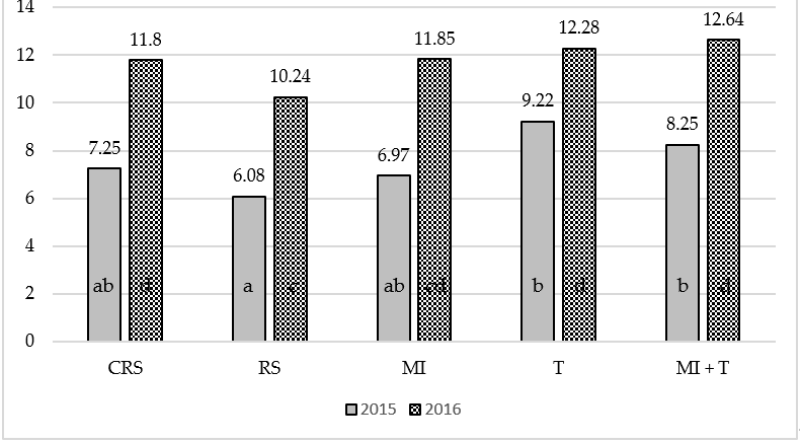
Figure 2. The apple tree trunk diameter (mm) in the years 2015 and 2016 (CRS = crop rotation soil; RS = replanted soil; MI = mycorrhizal inoculum; T = Trichoderma ; MI + T = mycorrhizal inoculum + Trichoderma ). Means marked with the same letters do not differ significantly at α = 0.05.